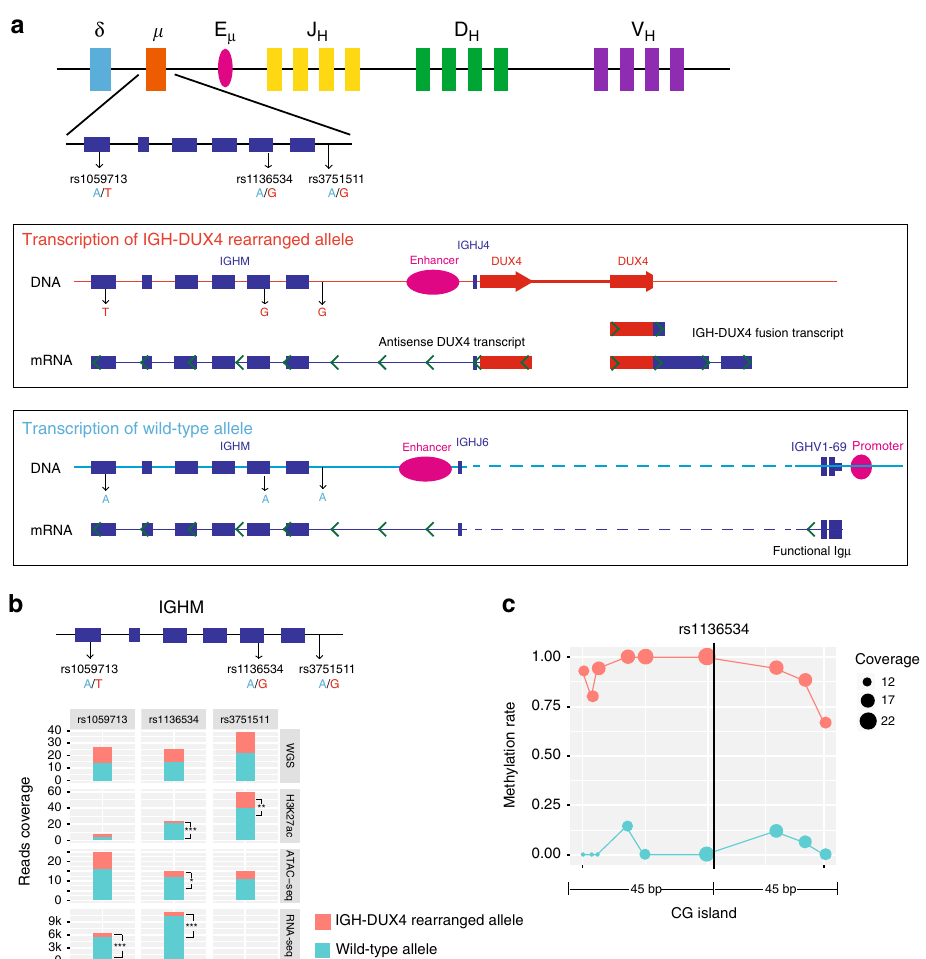
Fig. 2 Allele speci fi city of IGH - DUX4 translocation and functional Ig μ . a Diagram of DUX4 and IGH gene expression at two alleles in Nalm6. Functional Ig μ and antisense DUX4 are expressed from different alleles. Green arrows in transcripts indicate the direction of transcription. b Allelic imbalance of H3K27ac ChIP-seq, ATAC-seq, and RNA-seq data in the three heterozygous SNPs (rs1059713, rs1136534, rs3751511) located at IGHM . For RNA-seq, read-out is available only for the two exonic SNPs (rs1059713, rs1136534). One-tailed binomial test (expected probability 0.5) was performed: * p < 0.05, ** p < 0.01, *** p < 0.001. c Evaluation of allelic imbalance of DNA methylation near the SNP rs1136534 located in a CG island region. Each CpG site near the SNP is shown by a circle drawn in proportion to the reads coverage used for calculating the methylation ratio (see